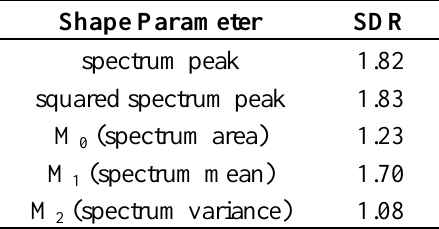
Table 5. Results of shape parameters evaluation by SDR criterion for free-rising bubble flow with a metallic plate obstructing the ultrasound